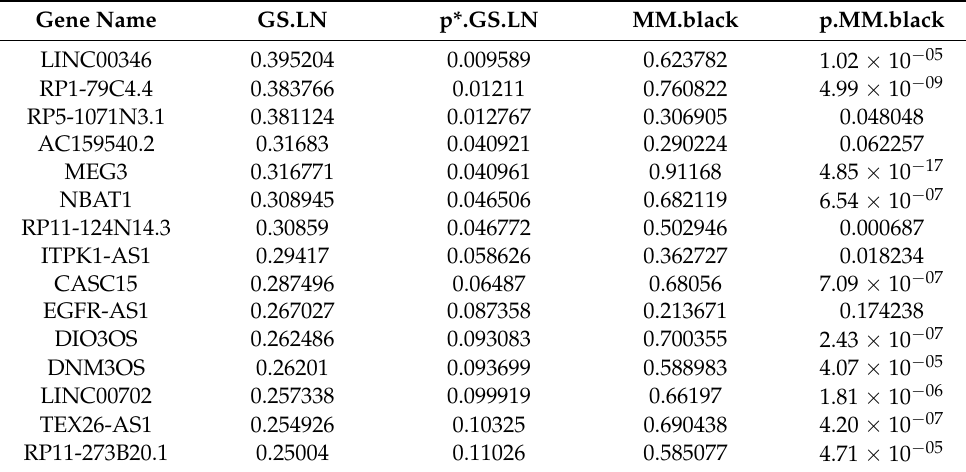
Table 2. Top 15 differentially expressed black module